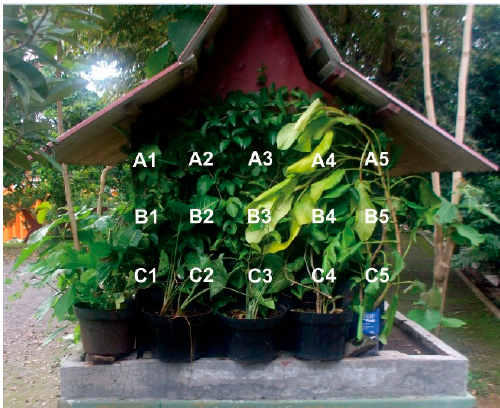
Figure 5. Location of measurement points for the surface temperature.